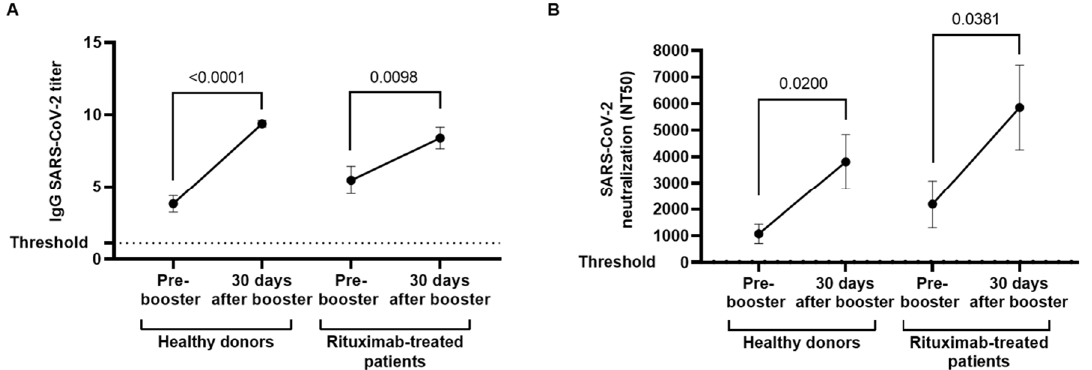
Figure 1. Serological response against COVID-19 vaccine in plasma of rituximab-treated patients and healthy donor before and after receiving the booster dose. ( A ) IgG titers in plasma from individuals with hematological disease who received rituximab before the second dose of vaccine (pre-booster) and the booster dose of SARS-CoV-2 vaccine, in comparison with healthy donors. ( B ) Neutralizing antibody titer at 50% inhibition (NT50) against SARS-CoV-2 of plasma isolated from individuals who received rituximab and healthy donors before and after the booster dose of COVID-19 vaccine. Each dot in the graphs corresponds to mean and the vertical lines correspond to standard error of the mean (SEM). Statistical significance within groups was calculated using the Wilcoxon signed-rank test.